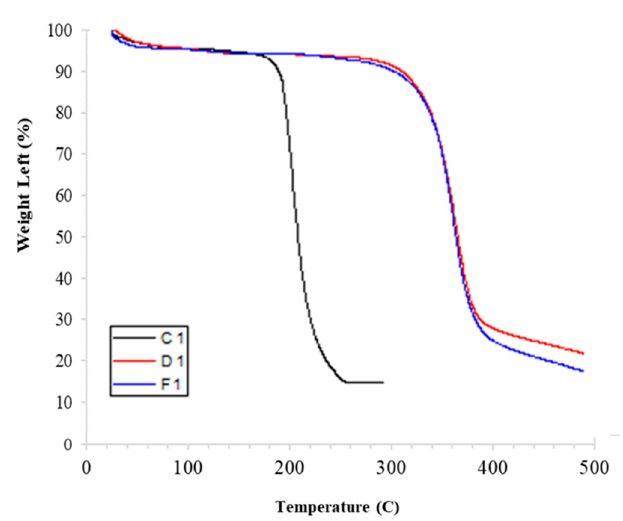
Figure 4. Thermogravimetric analysis (TGA) curves of different used membranes.